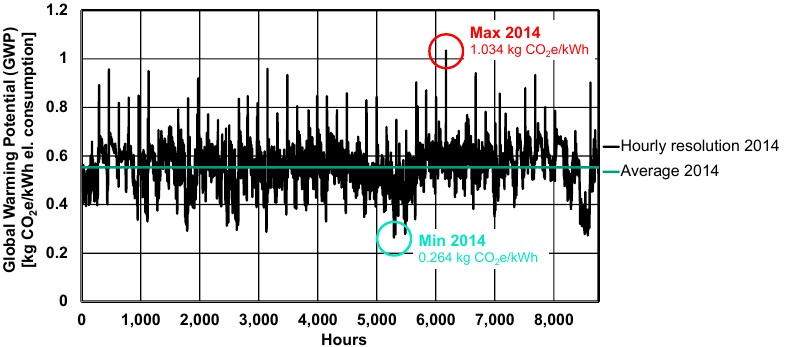
Figure 3. Hourly resolved global warming potential (GWP) of the German public electricity supply in 2014.